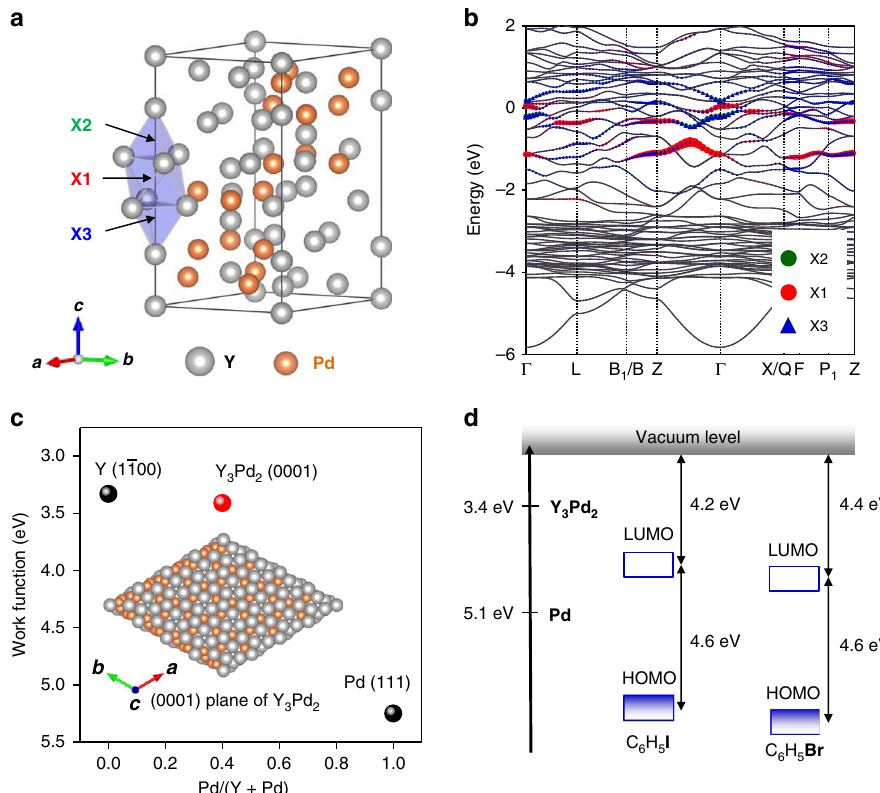
Fig. 1 Crystal and electronic structures of Y 3 Pd 2 . a Crystal structure of stoichiometric Y 3 Pd 2 . Y and Pd atoms are depicted as gray and orange balls, respectively. X1, X2, and X3 sites are indicated using black solid arrows. b Calculated band structure of stoichiometric Y 3 Pd 2 . The contributions of X1, X2, and X3 sites are indicated using red, green and blue dots, respectively. c Calculated work functions for the most stable surface, Y 3 Pd 2 (0001). The inset shows the 0001 surface of Y 3 Pd 2 . d Comparison of the Fermi level for Y 3 Pd 2 and the unoccupied (LUMO) states for aryl halides, iodobenzene, and